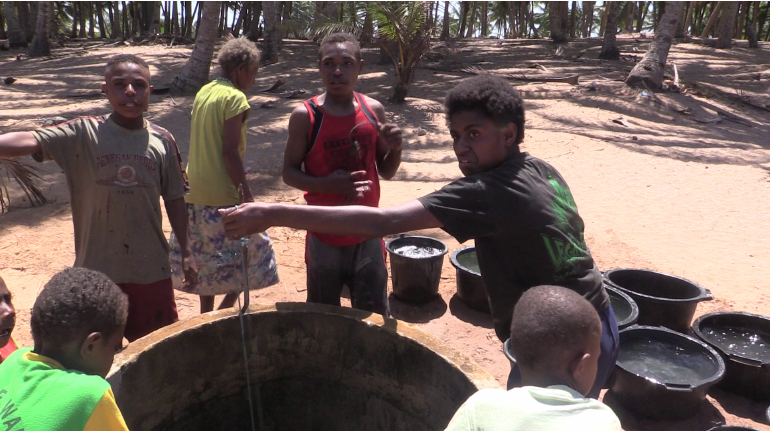
Figure 8: ‘Have you seen Meka?—He’s sitting there.’; cf. example